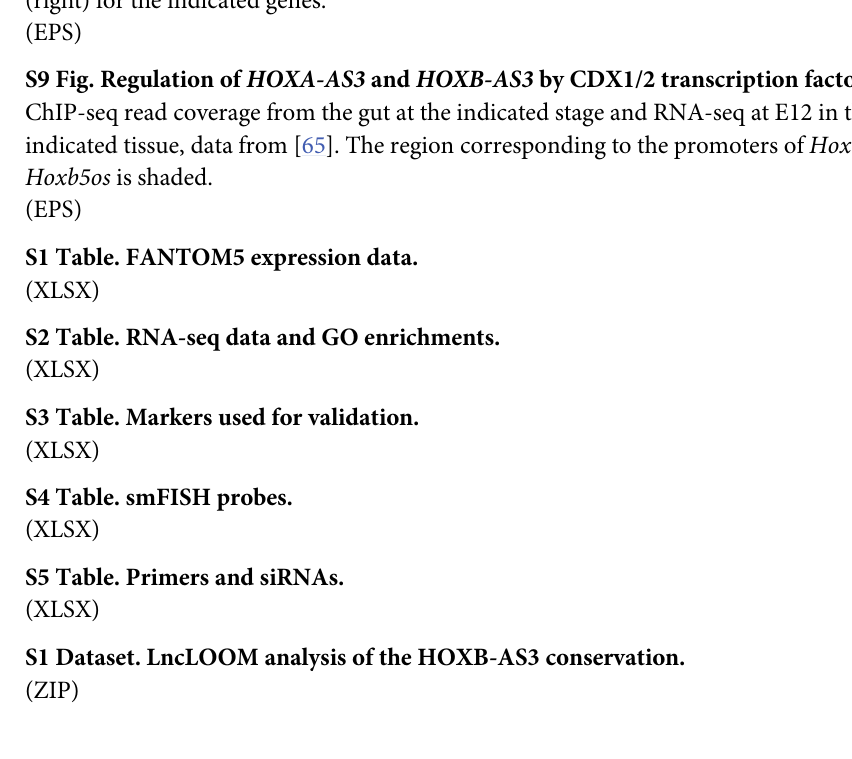
ESCs differentiated in different stages of differentiation. (F) As in Fig 7E (left) and Fig 7F (right) for the indicated genes. S9 Fig. Regulation of HOXA-AS3 and HOXB-AS3 by CDX1/2 transcription factors. CDX2 ChIP-seq read coverage from the gut at the indicated stage and RNA-seq at E12 in the indicated tissue, data from [65]. The region corresponding to the promoters of Hoxaas3 and Hoxb5os is shaded. S1 Table. FANTOM5 expression data. S2 Table. RNA-seq data and GO enrichments. S3 Table. Markers used for validation. S4 Table. smFISH probes. S5 Table. Primers and